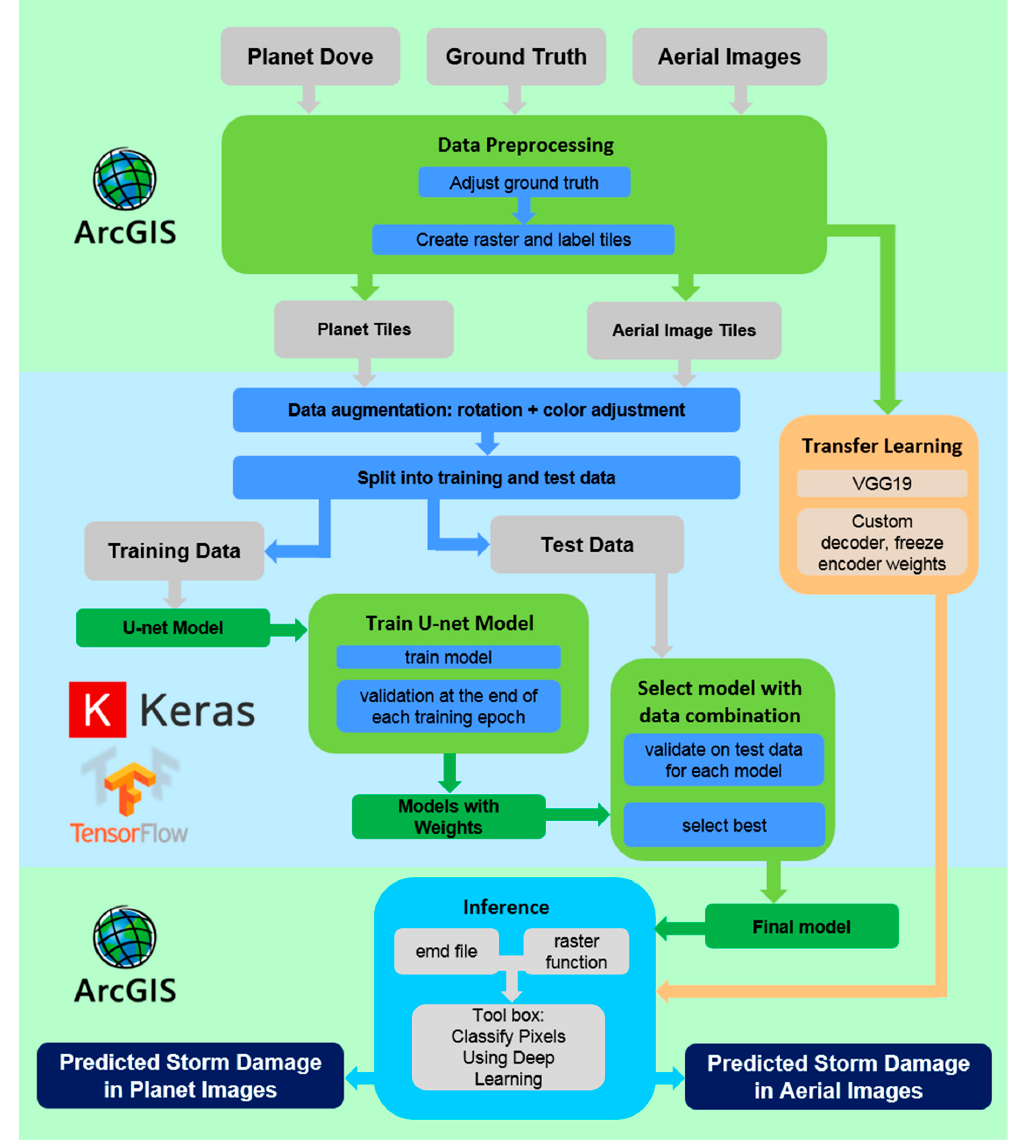
Figure 3. Flowchart showing the analytical workflow of the study.